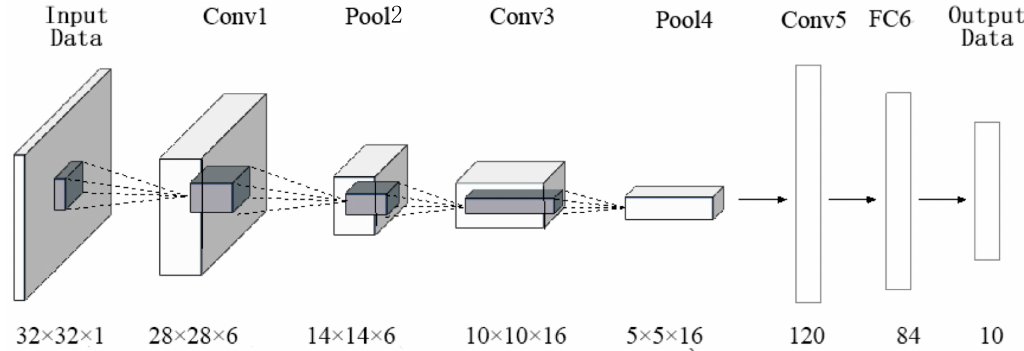
Figure 3. Framework of a typical convolutional neural network (CNN) model (LeNet5) (modified from reference [22]).